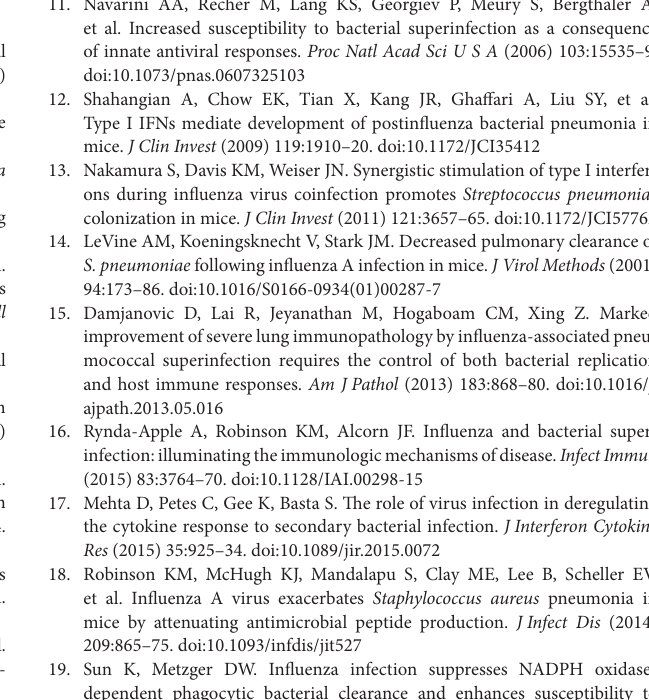
injected with SINV alone (green curves) or with Shigella alone (red curves), and non-injected fish (CTRL, black curves) as control. FigUre s6 | Possible correlation of cytokine expression levels and bacterial burden in Sindbis virus (SINV) + Shigella co-infected larvae. (a–D) Cytokine ( ifnphi1 , il1b , tnfa , il10 ) induction and bacterial content ( DsRed ) was measured from individual zebrafish larvae sequentially co-injected with SINV + Shigella (blue) or from individual zebrafish larvae injected with Shigella alone (red). Cytokine induction was correlated with bacterial content for each larva. Data plotted are from 3 independent experiments pooled ( n = 15 larvae for each condition, same larvae showed in Figure 5 ); individual values are shown. ViDeO s1 | (Related to Figure 4c ) Impaired neutrophil recruitment upon Sindbis virus (SINV)-local Shigella co-infection. Mpx :GFP larvae were injected in the bloodstream with SINV-GFP at 72 hpf and subcutaneously with Shigella - DsRed at 96 hpf (panel on the right of the movie), or subcutaneously with Shigella -DsRed only at 96 hpf as a control (panel on the left of the movie), and live imaged in the trunk region (where the bacteria were injected) every 2 min from 30 mpi ( t = 0 on the movie) to 3 h post infection ( t = 2 h 33 on the movie) simultaneously by confocal fluorescence microscopy. Immediately after the starting of the acquisition, some neutrophils (GFP + bright cells) had already recruited to the bacteria in both conditions. In Shigella -only infected larvae (left), more neutrophils were progressively recruited to the bacteria (DsRed + ), engulfing them quickly, and accumulating at the site of injection without any sign of cell death. In sequentially SINV + Shigella -injected larve (right), neutrophils poorly accumulated at the site of infection, and some underwent cell death upon engulfing bacteria. Note that SINV-GFP (GFP + diffuse signal) had replicated and invaded the muscle fibers of the trunk region. Maximum intensity projection is shown. Scale bar: 50 µm. ViDeO s2 | (Related to Figure 4e ) Impaired neutrophil survival upon Sindbis virus (SINV) + Shigella co-infection. A 72 hpf mpx :GFP larva was injected in the bloodstream with SINV-GFP and at 96 hpf subcutaneously with Shigella - DsRed, and live imaged immediately upon Shigella injection, every 1 ′ 30 ′′ from 30 mpi ( t = 0 on the movie) to 3 h 39 pi ( t = 3 h 09 on the movie). Six engulfing neutrophils (GFP + bright cells, indicated by arrows on the movie) were manually tracked over time. Note the SINV-GFP infected cells (diffuse GFP signal, muscle fibers, and mesenchyme in the left bottom corner of the field). Injection site, maximum intensity projection. Scale bar: 20